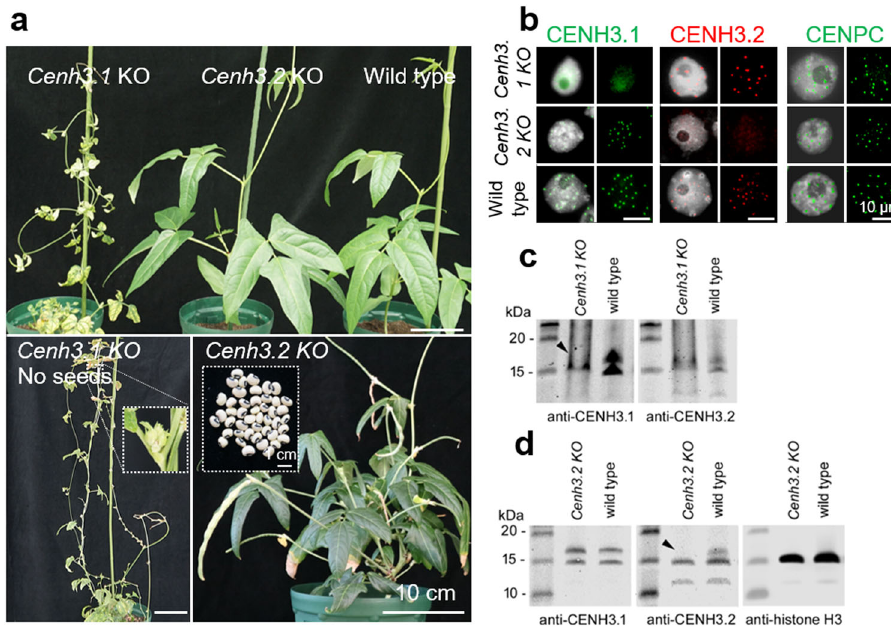
Fig. 2 Characterization of Cenh3.1 and Cenh3.2 KO plants of cowpea induced by CRISPR/Cas9-based genome editing and of cowpea CENH3 variant- speci fi c antibodies. a Plant growth phenotype of Cenh3.1 , Cenh3.2 KO, and wild-type plants. Note the retarded growth of Cenh3.1 KO plants. Cenh3.1 KO plants produce no seeds, while Cenh3.2 KO plants from seeds (insert). b Indirect immunostaining of isolated nuclei from wild-type, Cenh3.1, and Cenh3.2 KO plants with anti-CENH3.1 (green), anti-CENH3.2 (red), and anti-CENPC (green) antibodies. c , d Comparative western blot of isolated nuclear proteins from wild-type, Cenh3.1 and Cenh3.2 KO plants with c anti-CENH3.1 and d anti-CENH3.2. Arrows indicate the position of the missing CENH3 band in KO plants. d Anti-histone H3 was used for positive